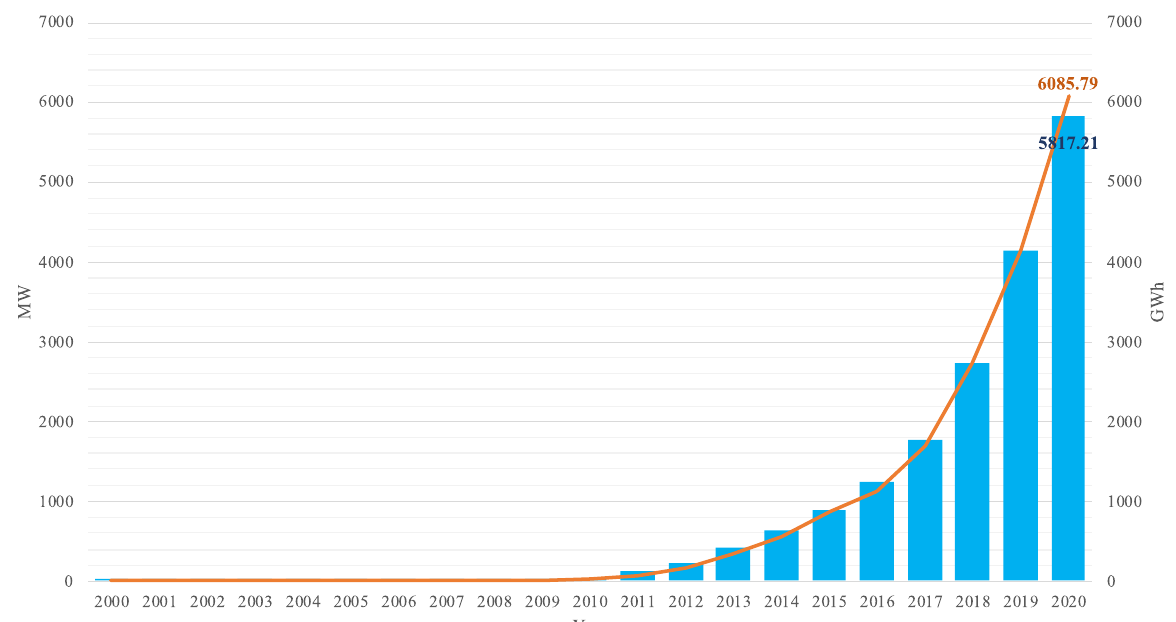
Figure 1. Photovoltaic cumulative installed capacity and power generation Source: [12], self-elaboration.